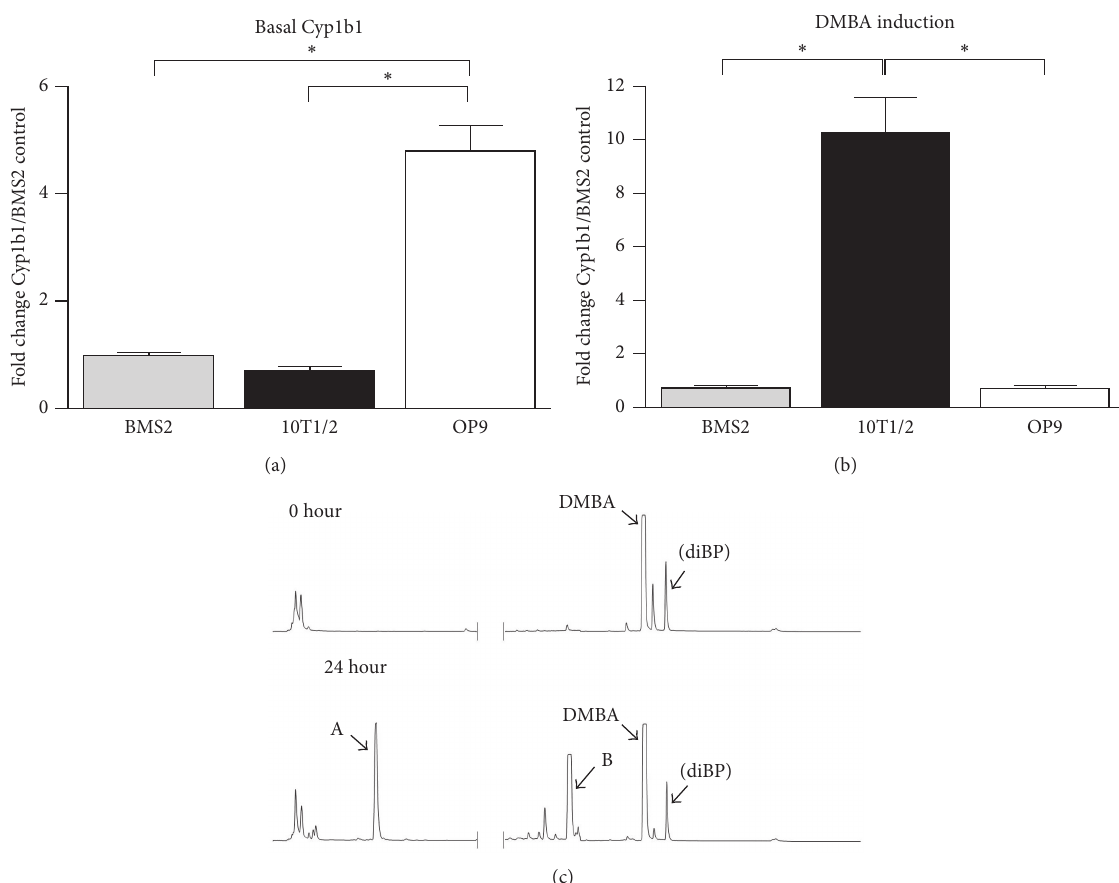
Figure 4: Cyp1b1 induction and DMBA metabolism in OP9 cells compared to other mouse multipotential progenitor lines. (a) Comparison of basal Cyp1b1 mRNA expression in OP9, C3H10T1/2 (10T1/2) cells, and BMS2 cells (set to 1.0). ∗ 𝑝 < 0.05 . (b) DMBA (24 hours, 1 𝜇 M) induction of Cyp1b1 mRNA in 10T1/2 cells but not BMS2 and OP9 cells. ∗ 𝑝 < 0.05 . (c) HPLC separation of DMBA metabolites after zero- and 24-hour incubation of 3 𝜇 M DMBA with OP9 cells (A: unresolved 8,9- and 10,11-dihydrodiols; B: unresolved 7- and 12-hydroxylmethyl). DiBP is added as an extraction standard after termination of the